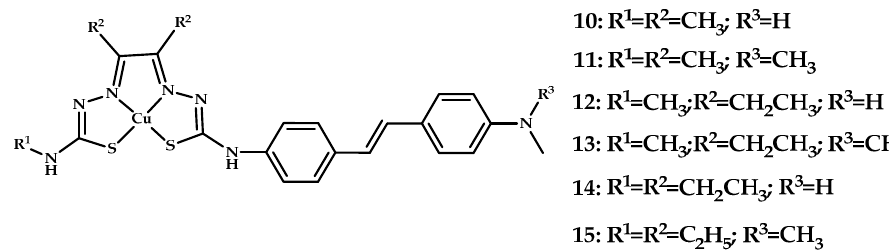
Figure 6. Cu(II)–ATSM derivatives conjugated with stilbene functional groups 10 – 15 , designed for A β fibrils visualization.